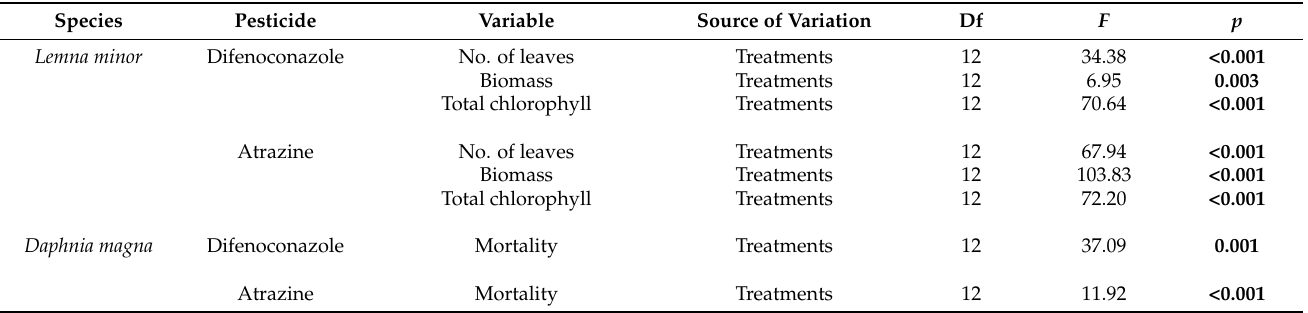
Table 2. Summary of the GLM for the number of leaves, biomass, and total chlorophyll of L. minor and for the percentage of mortality of D. magna after being exposed to different concentrations (treatments) of difenoconazole and atrazine pesticides. Significant differences are indicated with the p -values in bold.